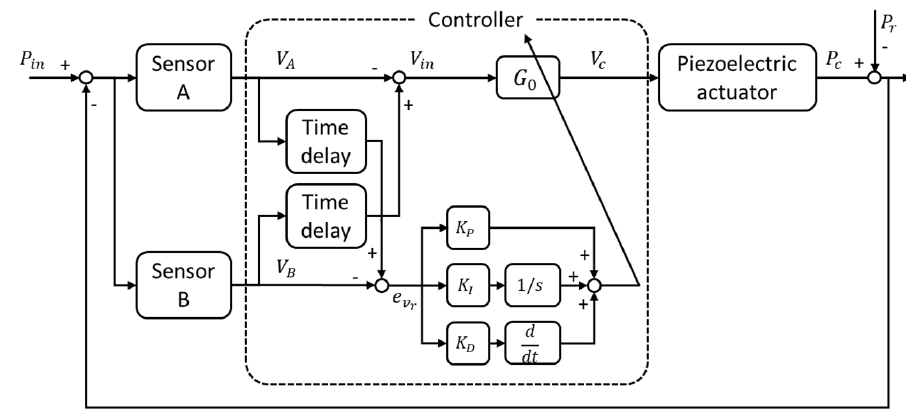
Figure 12. Block diagram of the proposed adaptive feedback control scheme.